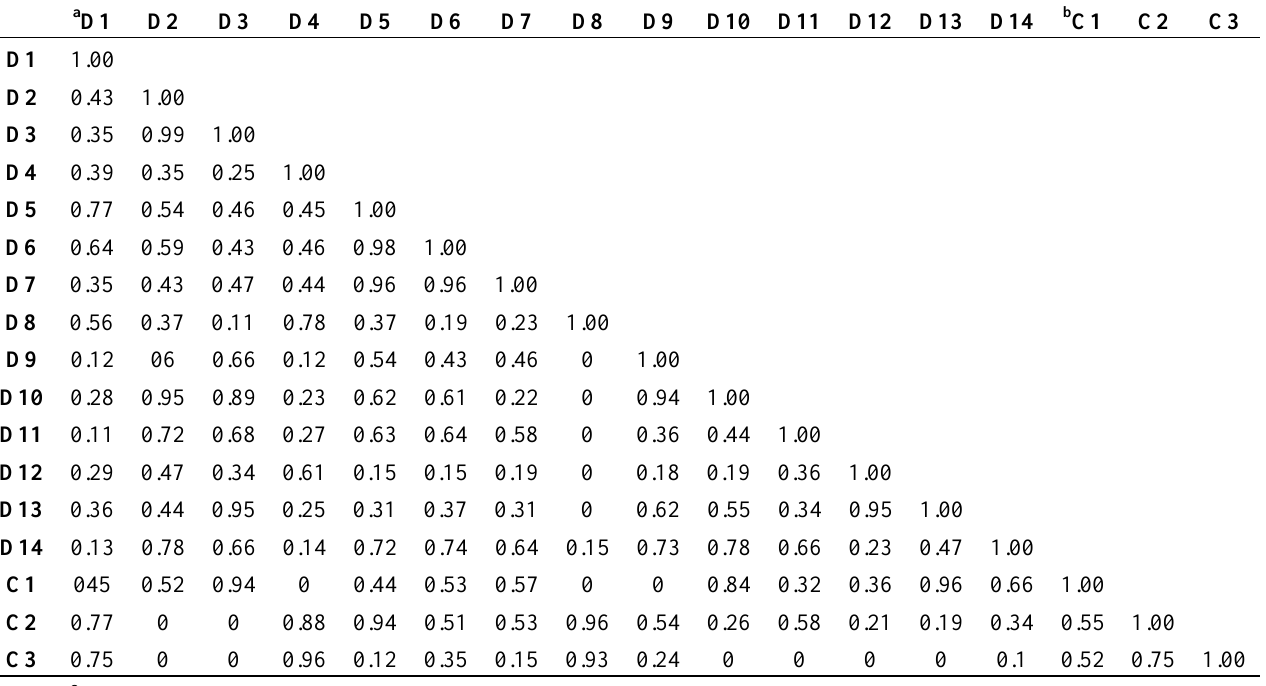
Table 4. Correlation matrix of biological activity with molecular